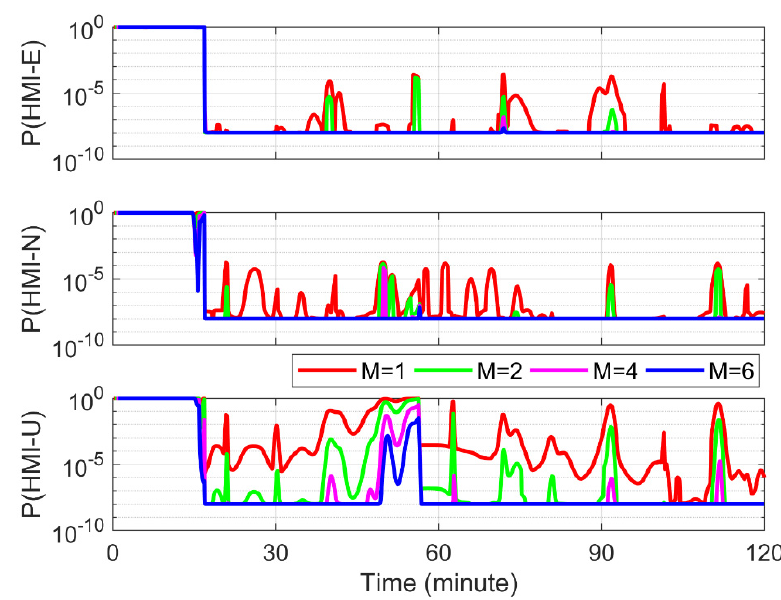
Figure 7. The integrity risk for the east ( top ), north ( middle ) and up ( bottom ) direction using windows of different lengths.